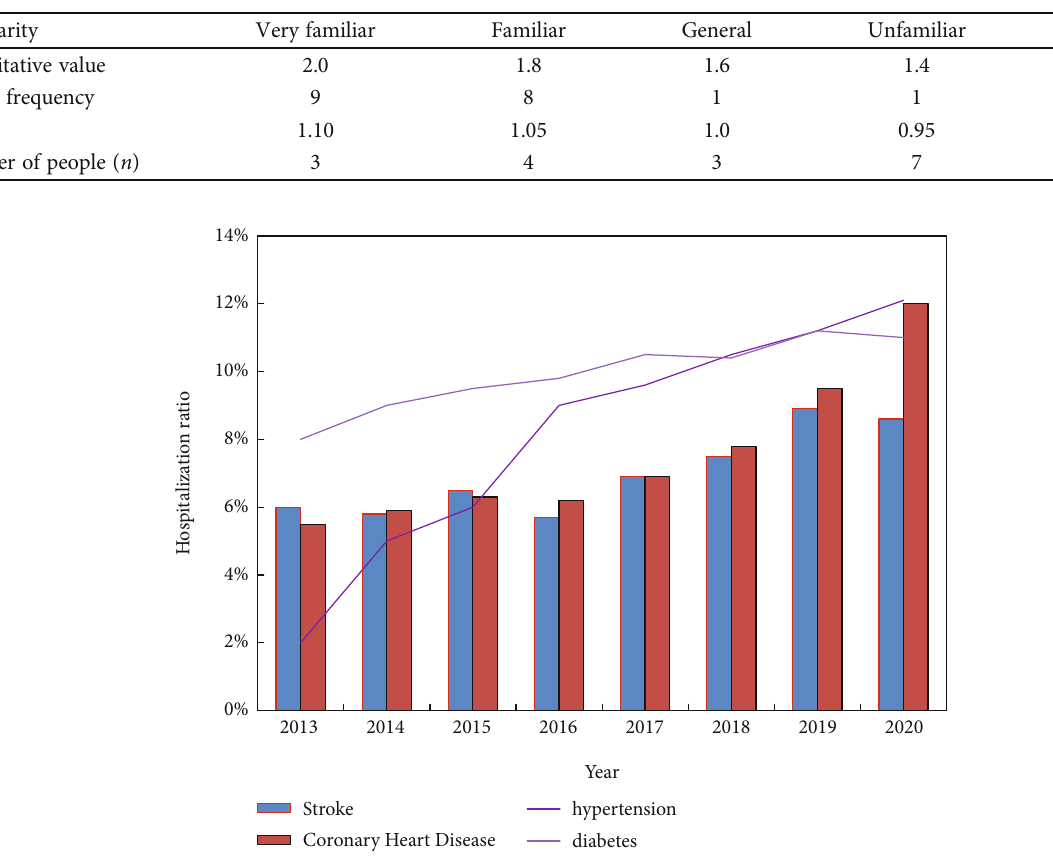
Figure 7: Four trends in the proportion of patients with common chronic diseases in